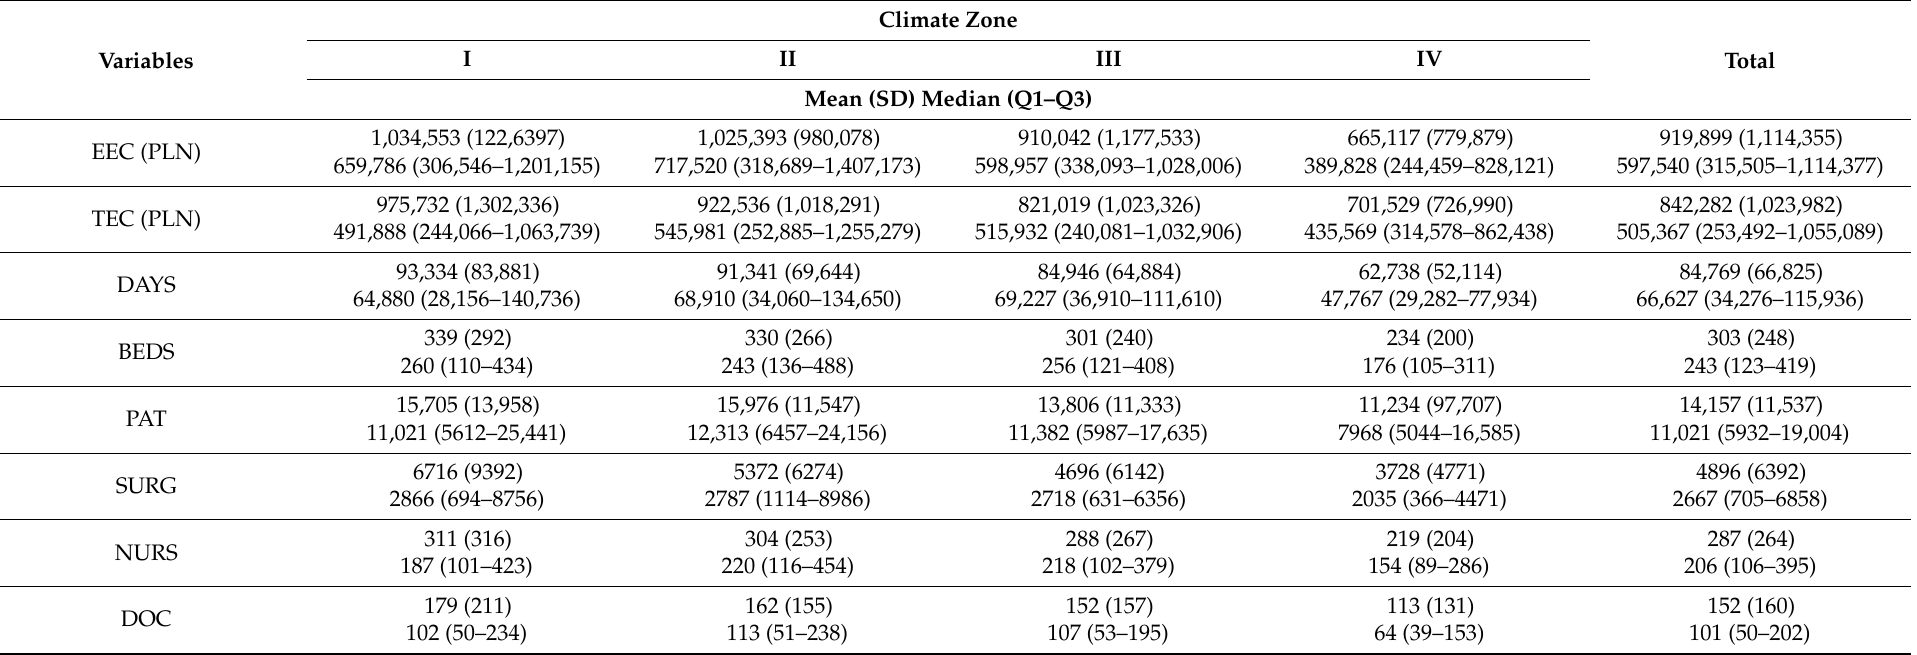
Table 3. Characteristics of analyzed hospitals according to the climate zones in